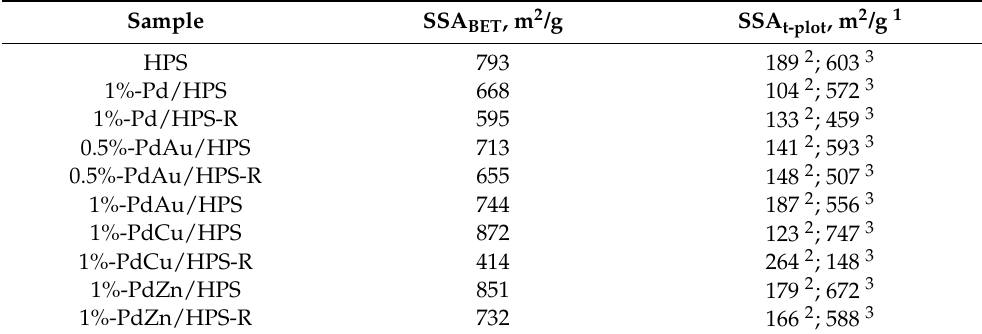
Table 1. SSA of the initial HPS and fresh mono- and bimetallic catalysts obtained by liquid nitro- gen physisorption.